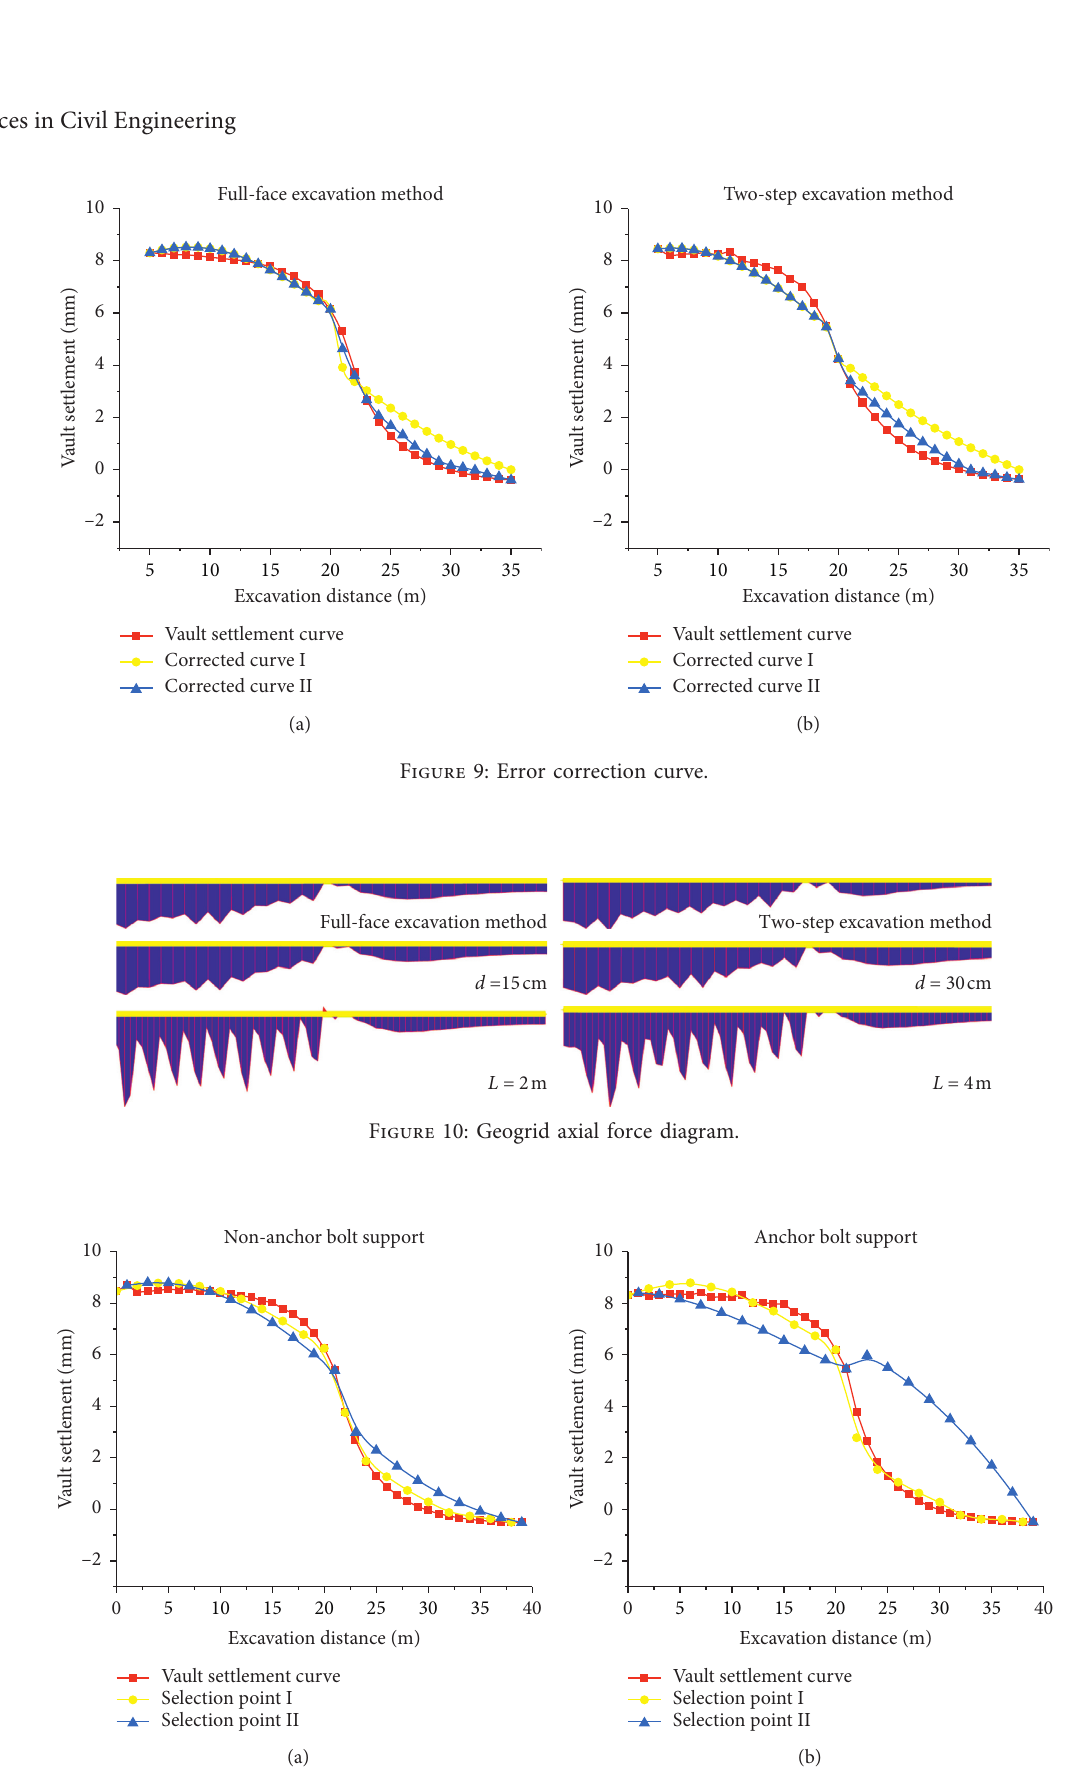
Figure 11: Deformation reconstruction under different selection